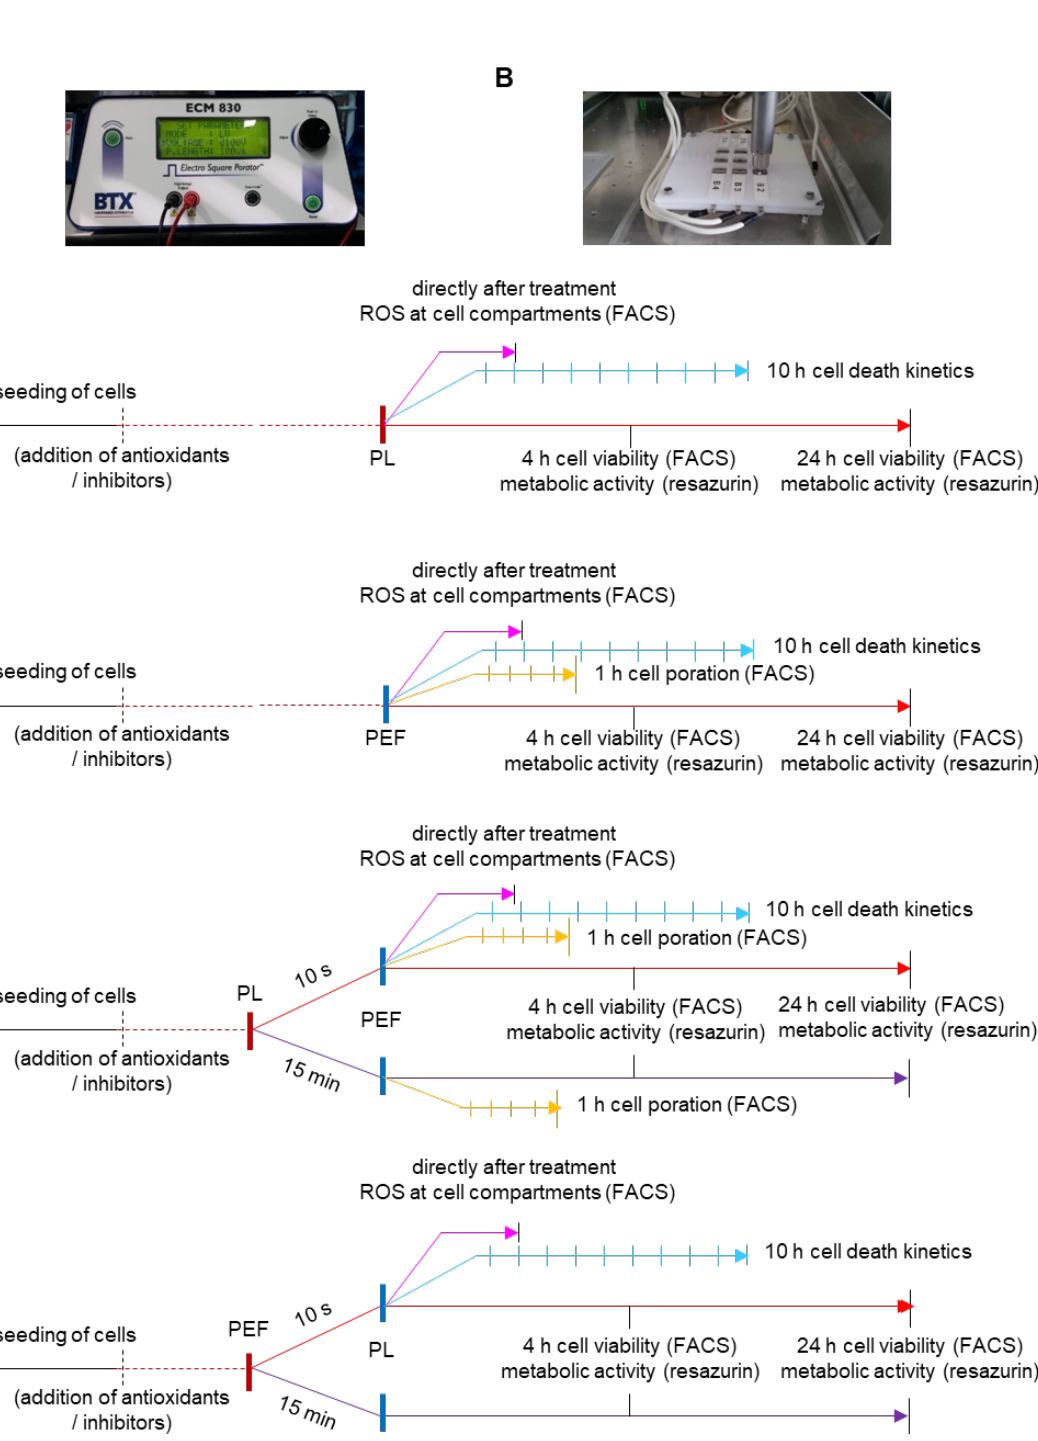
Figure 1. Experimental design. The electro square porator ( A ) was used for the application of pulsed electric fields. The cells were seeded in square Petri dishes, and a specially designed lid with electrodes allowed simultaneous treatment of plasma and PEF ( B ). A schematic overview of the mono treatments, plasma ( C ), and PEF ( D ), as well as the combination treatments, with first plasma and PEF second ( E ), and vice versa ( F ). PL = plasma; PEF = pulsed electric fields.